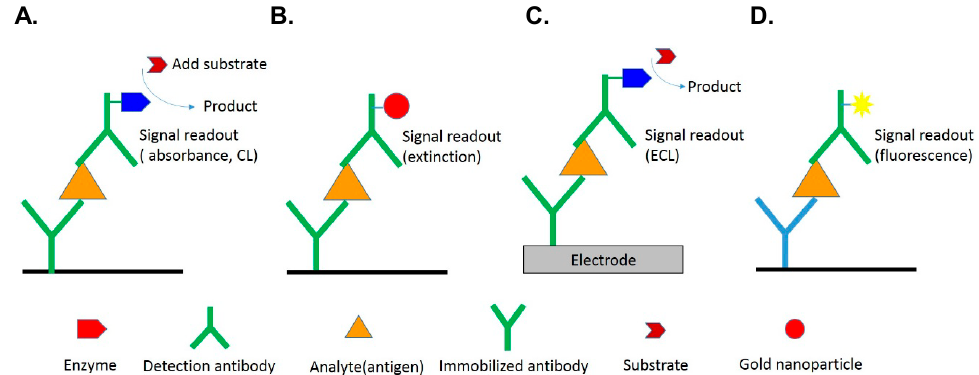
Figure 1. Comparison of immunosensing with optical probes. ( A ) Colorimetric and chemiluminescence (CL) induced by an enzyme; ( B ) Colorimetric changes by light absorption and scattering of a nanoparticle; ( C ) Electrochemiluminescence (ECL) from an electrochemically excited probe; ( D ) Photoluminescence from an optically excited probe.